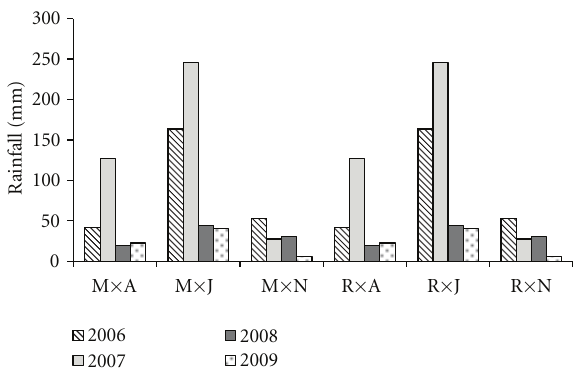
Figure 4: Accumulated rainfall two weeks prior to sampling date. Monoculture (M) and rotation (R) in the di ff erent seasons (J = July; A = August; N = November) (data ARC—Institute for Soil, Climate and Water, AgroClimatology Programme, Stellenbosch, South Africa).